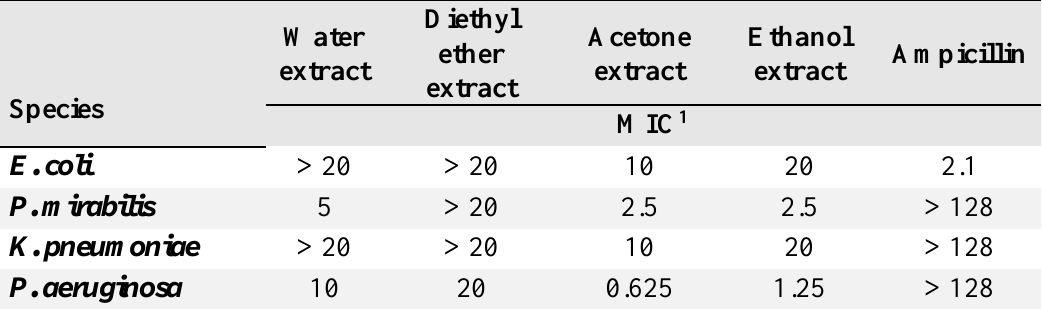
Table 1. Antibacterial activity of the extracts of Agrimonia eupatoria L. (M URUZOVI Ć et al .,